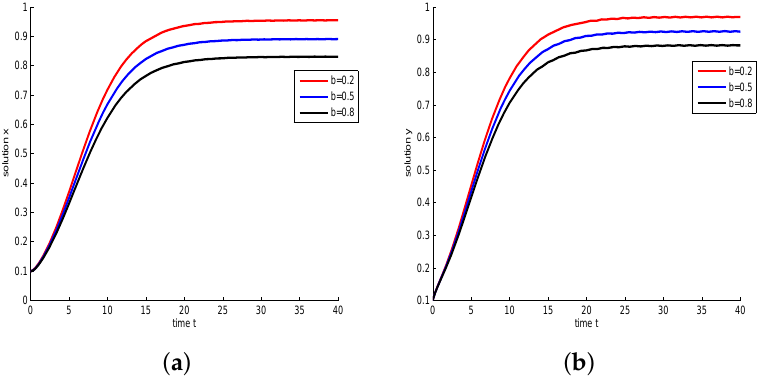
Figure 6. Take b = 0.2, b = 0.5, b = 0.8, respectively, and ( x ( 0 ) , y ( 0 )) = ( 0.1,0.1 ) . In this case, E 3 is a stable node. ( a ) Juvenile species. Numerical simulation of juvenile species x of Model (22). ( b ) Adult species. Numerical simulation of adult species y of Model